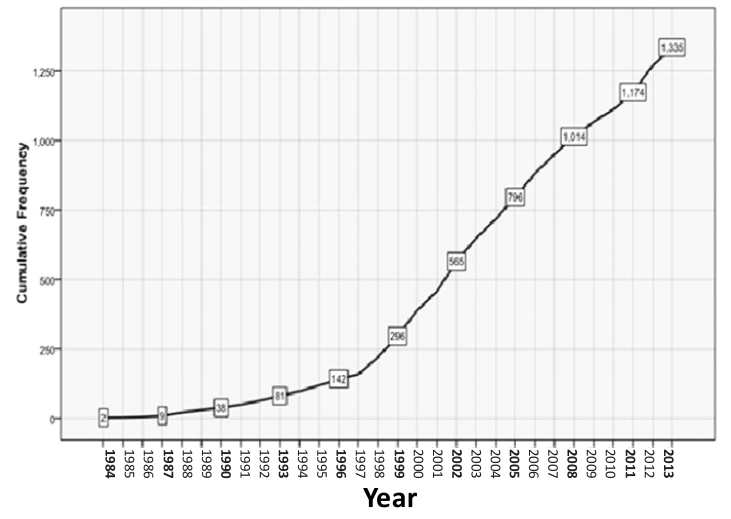
Figure 1. Help seeking pattern over 29